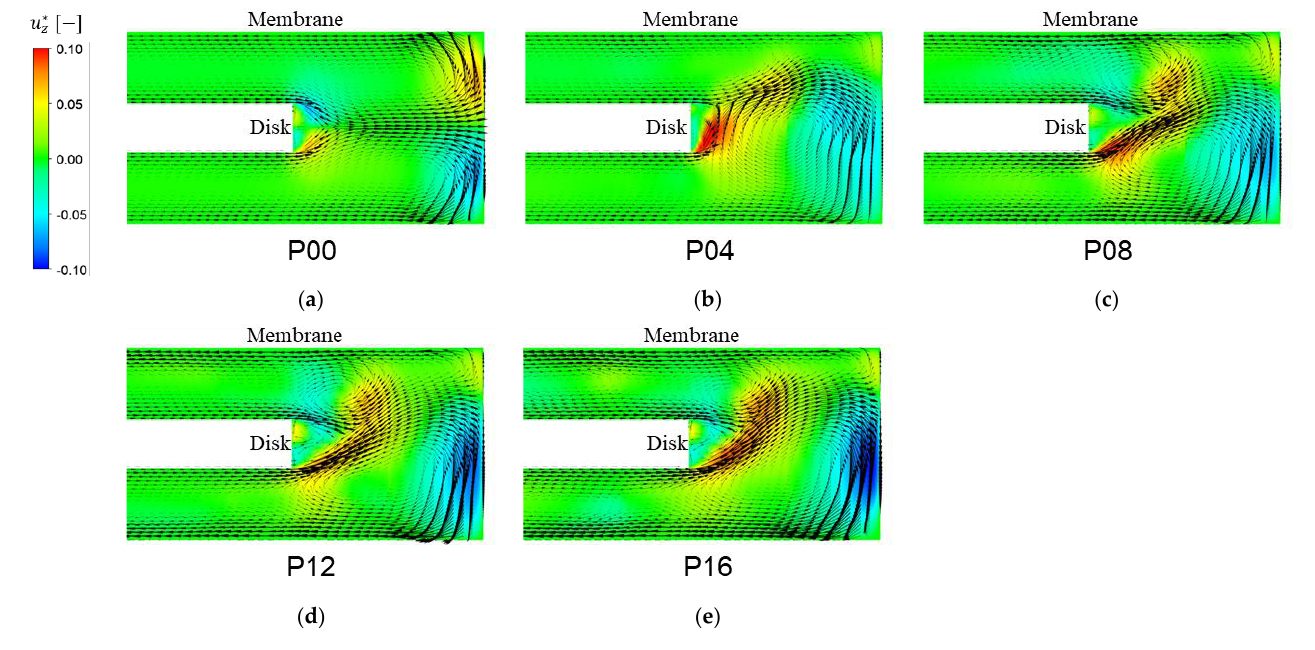
Figure 7. The cross-sectional velocity vectors (in the 𝑧𝑥 -plane) influenced by the number of patterns 𝑁 𝑝 when 𝛺 = 200 rpm. The color contour in each plot represents the value of the dimensionless axial velocity ( 𝑢 𝑧∗ ) defined by 𝑢 𝑧∗ = 𝑢 𝑧 /(𝛺𝑅 𝑖 ) . ( a ) 𝑁 𝑝 = 0 (plain disk), ( b ) 𝑁 𝑝 = 4 , ( c ) 𝑁 𝑝 = 8 , ( d ) 𝑁 𝑝 = 12 , and ( e ) 𝑁 𝑝 = 16 .